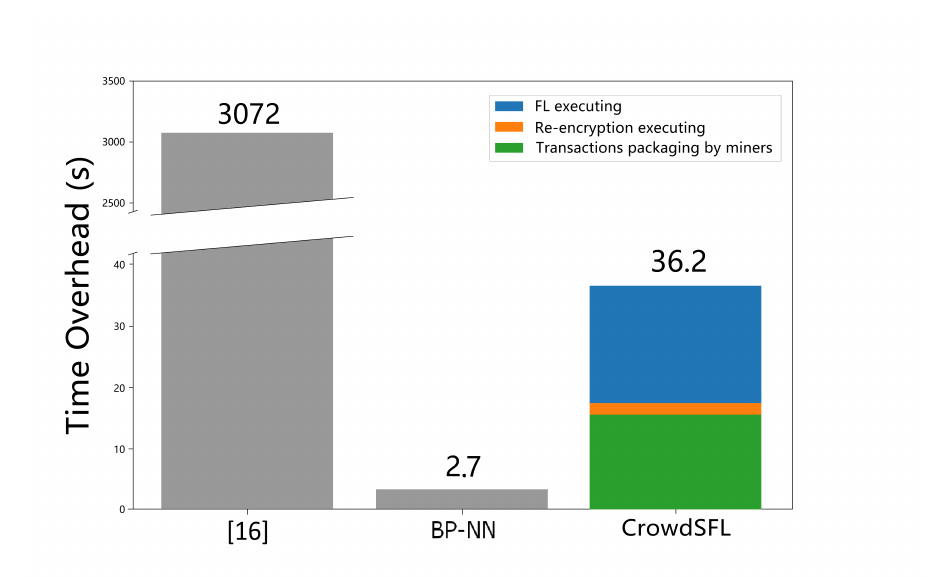
Figure 4. The time overhead of CrowdSFL, BP-NN, and